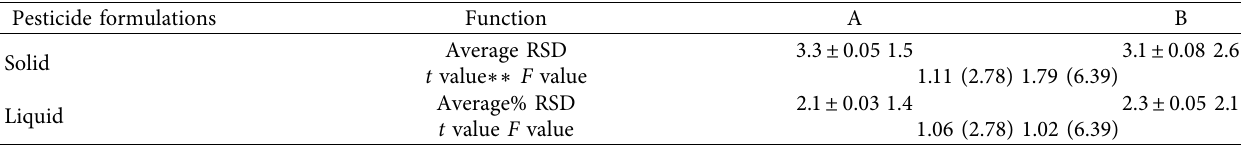
Table 2: Average concentrations of malathion determined in solid (mg g − 1 ) and liquid (mg mL − 1 ) pesticide formulations by the developed SW-CSV (a) and the standard GC-MS (b) methods ∗ .